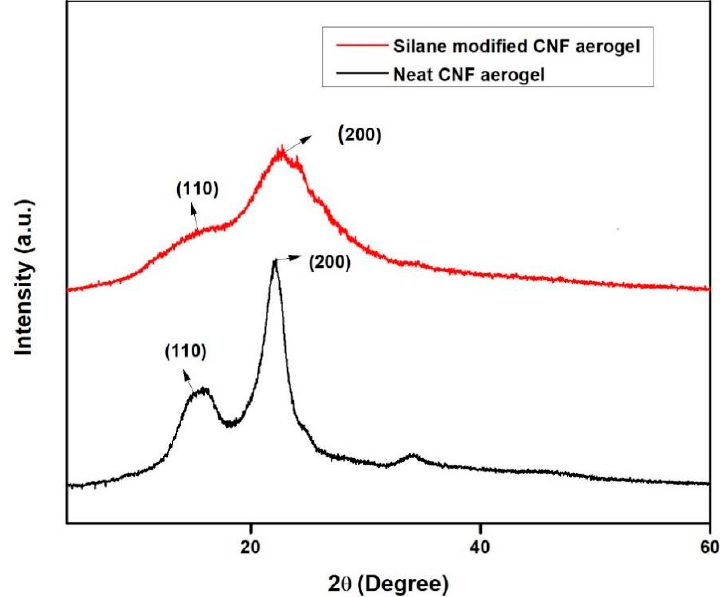
Figure 5. The XRD patterns of the neat CNF aerogel and silane-modified CNF aerogel.